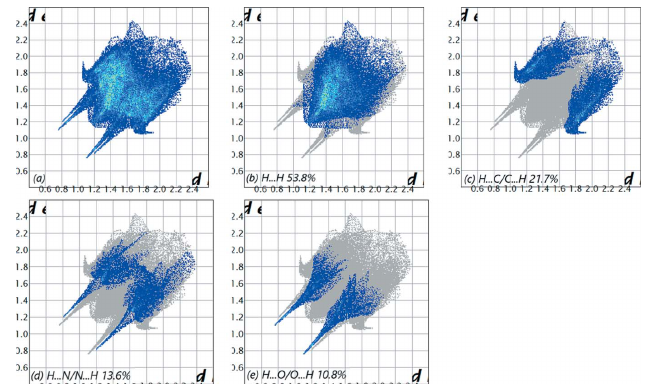
Figure 6 The full two-dimensional fingerprint plots for the title compound, showing ( a ) all interactions, and those delineated into ( b ) H (cid:2)(cid:2)(cid:2) H, ( c ) H (cid:2)(cid:2)(cid:2) C/C (cid:2)(cid:2)(cid:2) H, ( d ) H (cid:2)(cid:2)(cid:2) N/N (cid:2)(cid:2)(cid:2) H and ( e ) H (cid:2)(cid:2)(cid:2) O/O (cid:2)(cid:2)(cid:2) H interactions. The d i and d e values are the closest internal and external distances (in A˚ ) from given points on the Hirshfeld surface. lowest unoccupied molecular orbital (LUMO) energy level is shown in Fig. 7. The HOMO and LUMO are localized in the plane extending over the whole N -(2-amino-5-methylphenyl)- 2-(5-methyl-1 H -pyrazol-3-yl)acetamide system. The energy